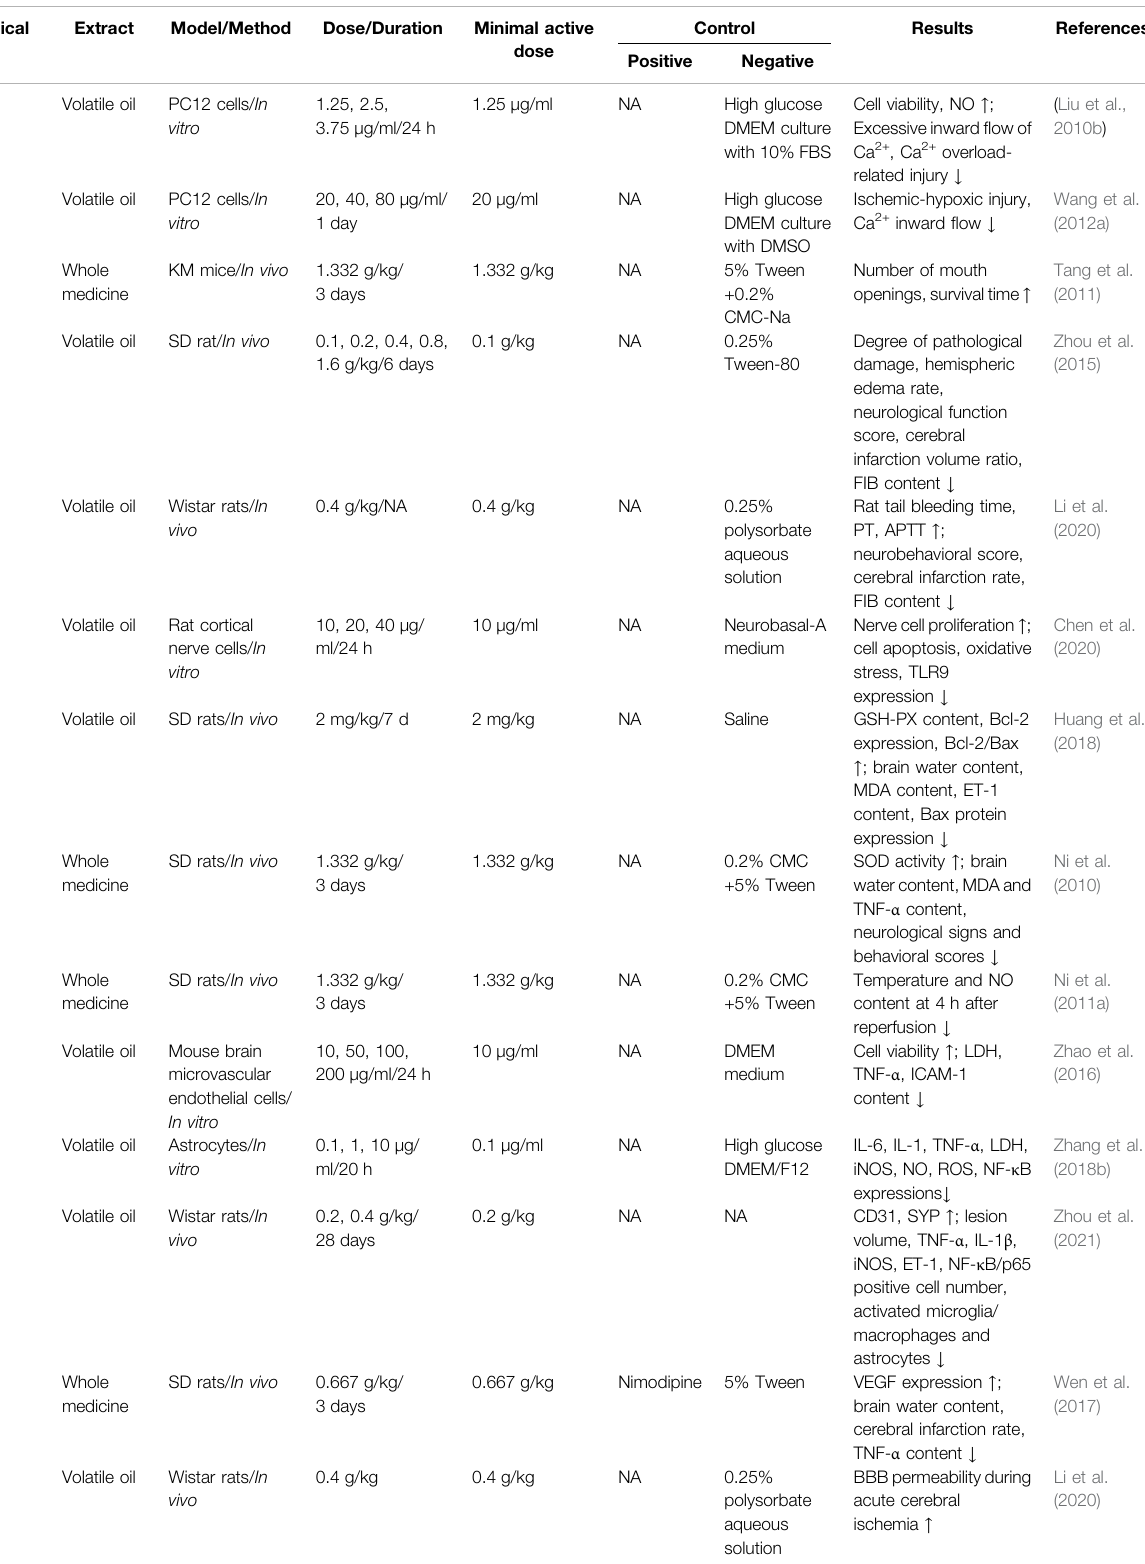
TABLE 3 | Pharmacological effects of storax on cerebrovascular diseases ( “ ↓ , ” decrease; “ ↑ , ” increase). Pharmacological